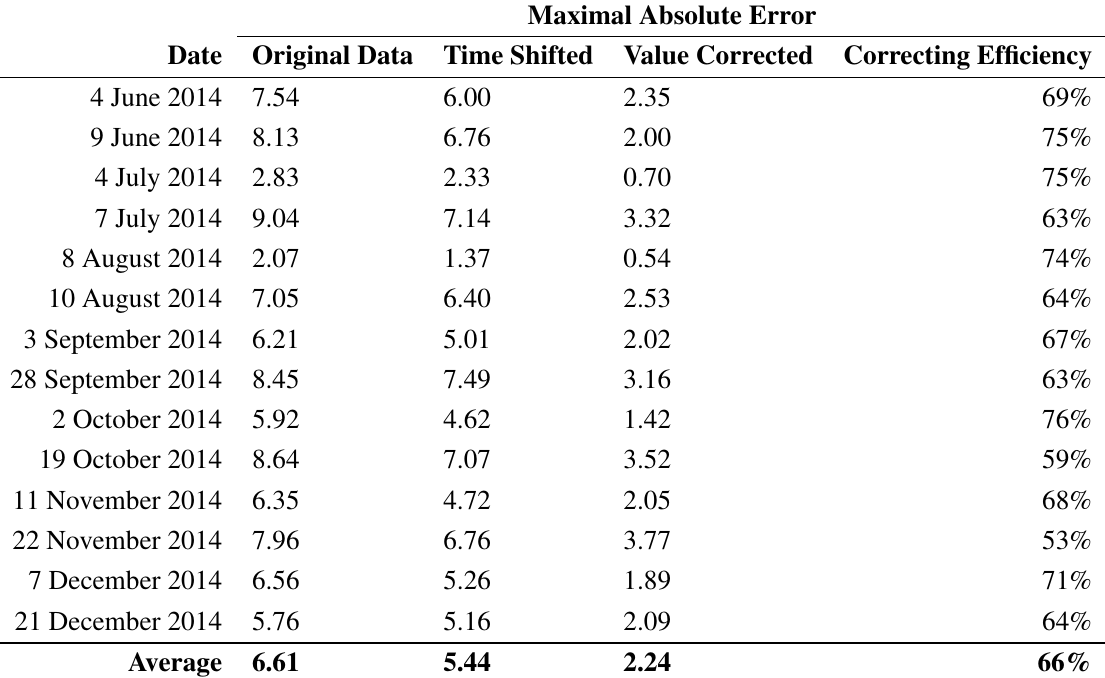
Table 3. Maximal absolute error in different correcting phases.